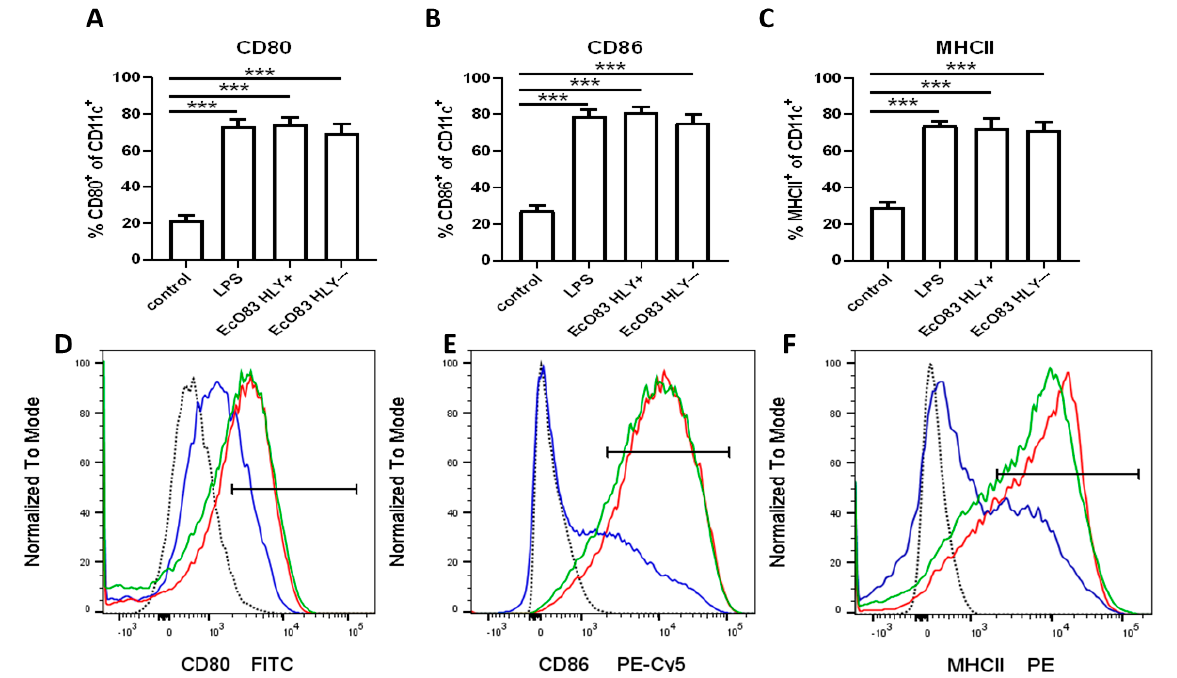
Figure 1. The capacity of probiotic strains of E. coli O83:K24:H31 (EcO83), either with hemolysin (HLY+) or without hemolysin (HLY-) activity to promote maturation of bone marrow–derived cells (BMDC) evaluated by flow cytometry. After 24 h of cocultivation of BMDC with EcO83 HLY+, EcO83 HLY-, or lipopolysaccharide (LPS), activation markers were followed. Columns represent median with standard error mean from six independent experiments. ( A )—cell surface presence of CD80; ( B )—cell surface presence of CD86; ( C )—cell surface presence of MHCII on BMDC. Representative histograms documenting cell surface presence of activation markers on non-stimulated (blue line), EcO83 HLY+ stimulated (green line) and LPS-stimulated (red line) bone marrow–derived dendritic cells are shown for CD80 ( D ), CD86 ( E ) and MHCII ( F ). Dotted lines stand for histograms of FMO (fluorescence minus one) control. *** p ≤ 0.001